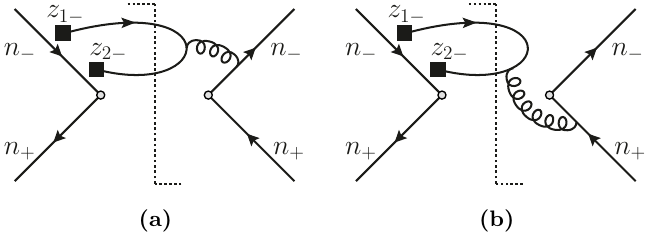
Figure 4. Diagrams contributing to the S 5 soft function. Same conventions as in figure 1 are used. The filled squares in this figure stand for the soft covariant derivative and the Wilson lines contained in q + ( z 1 − ) ¯ q + ( z 2 − )